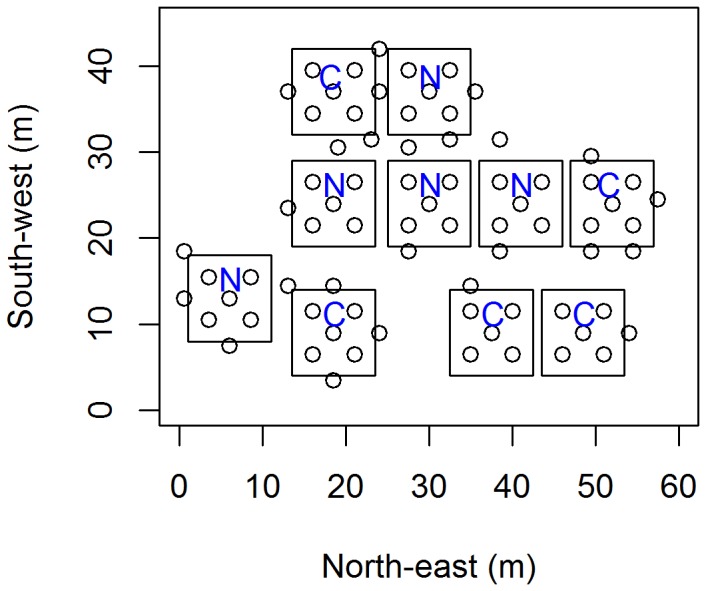
The spatial sample point pattern of the field used for gastropods and beetles.Each sample point is represented by a circle given by x and y coordinates based on distance (in meters). Treatment = nematode treatment.